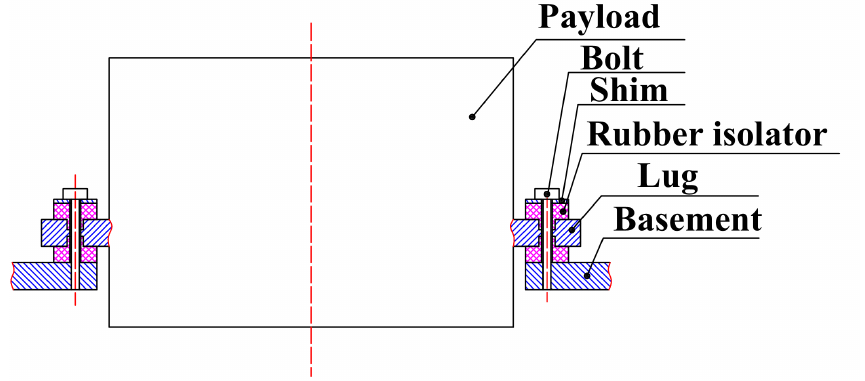
Figure 5. Stretch of the isolation system.